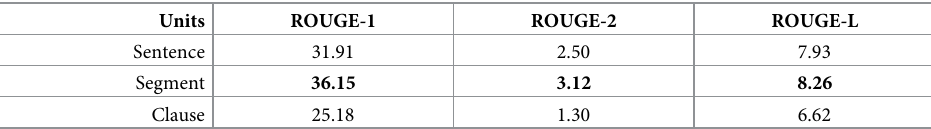
Table 6. Results of the summarization task.